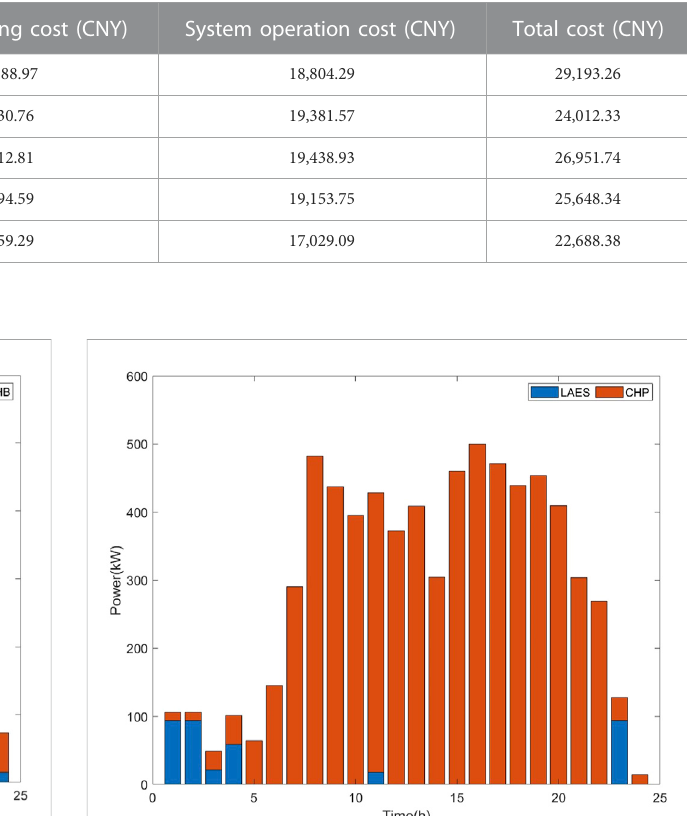
FIGURE 7 Flow direction of thermal power generated by GT.